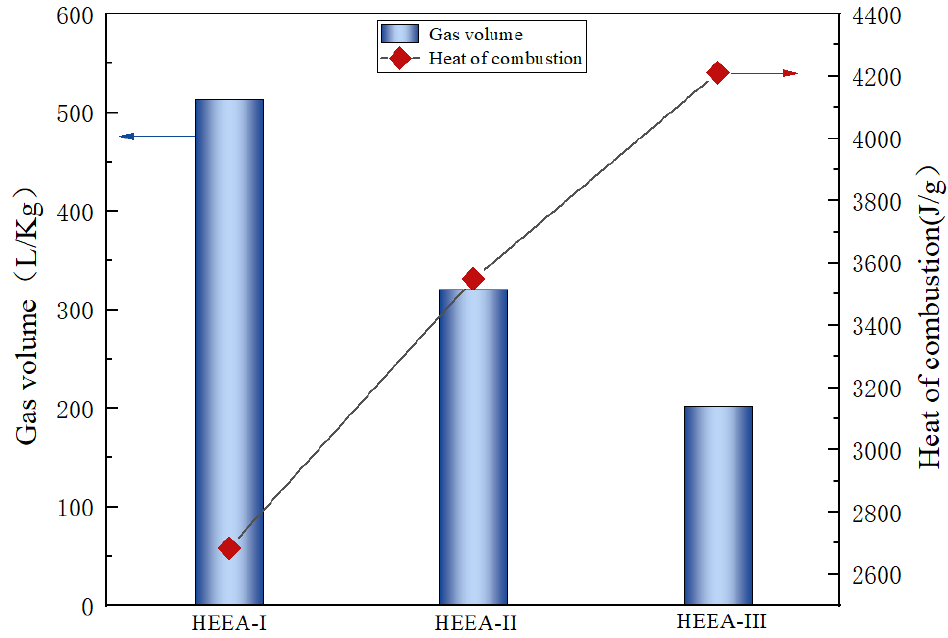
Figure 9. Combustion heat and gas specific volume of high-energy expansion agent. The gas specific volume V HEEA-I of HEEA-I is 513 L/kg, which is 60.31% and 153.96% higher than that of V HEEA-II and V HEEA-III , respectively. It can be seen that the combustion heat and gas specific volume of the three types of HEEA are negatively correlated, and the gas specific volume of HEEA-III with higher heat is only 202 L/kg. Gas is the medium of energy output, and the molecular weight of gas determines the performance of expansion work [27]. Therefore, the gas specific volume is a key factor for the work performance of HEEA. The combustion reaction process of HEEA is a high-speed and high-efficiency combustion mode, with the thermodynamic characteristics of isovolumetric combustion, which can rapidly release high-energy mechanical energy. It can be seen from formula (4) that in the process of HEEA combustion reaction of the same mass, the expansion work relationship of the gas to the outside world is W HEEA-I > W HEEA-II > W HEEA-III